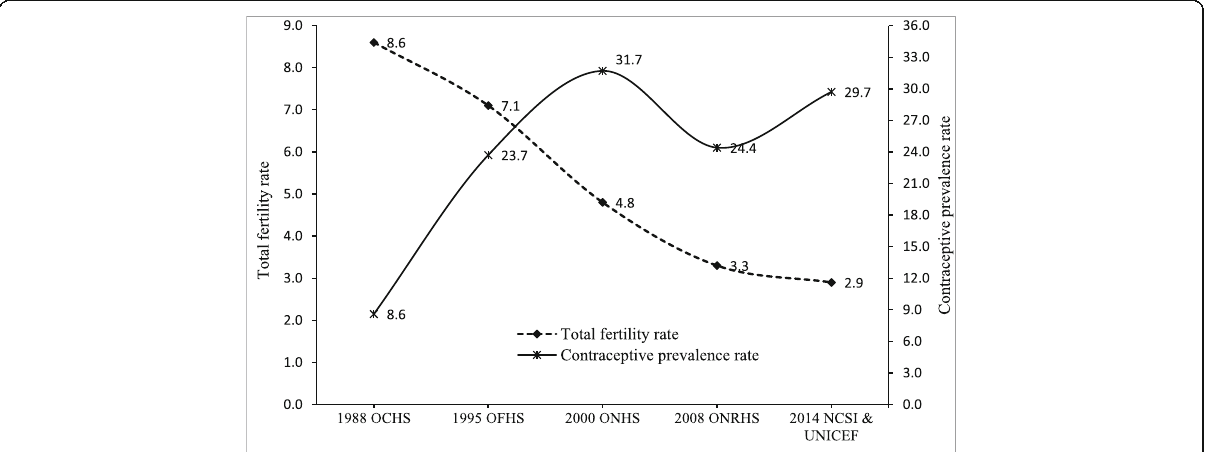
Fig. 3 Estimates of total fertility rates (TFRs) and contraceptive prevalence rates (CPRs) in Oman from different national level surveys between 1988 and 2014. Source: Sulaiman et al., [23, 24], Al-Riyami et al. [25, 26], NCSI & UNICEF